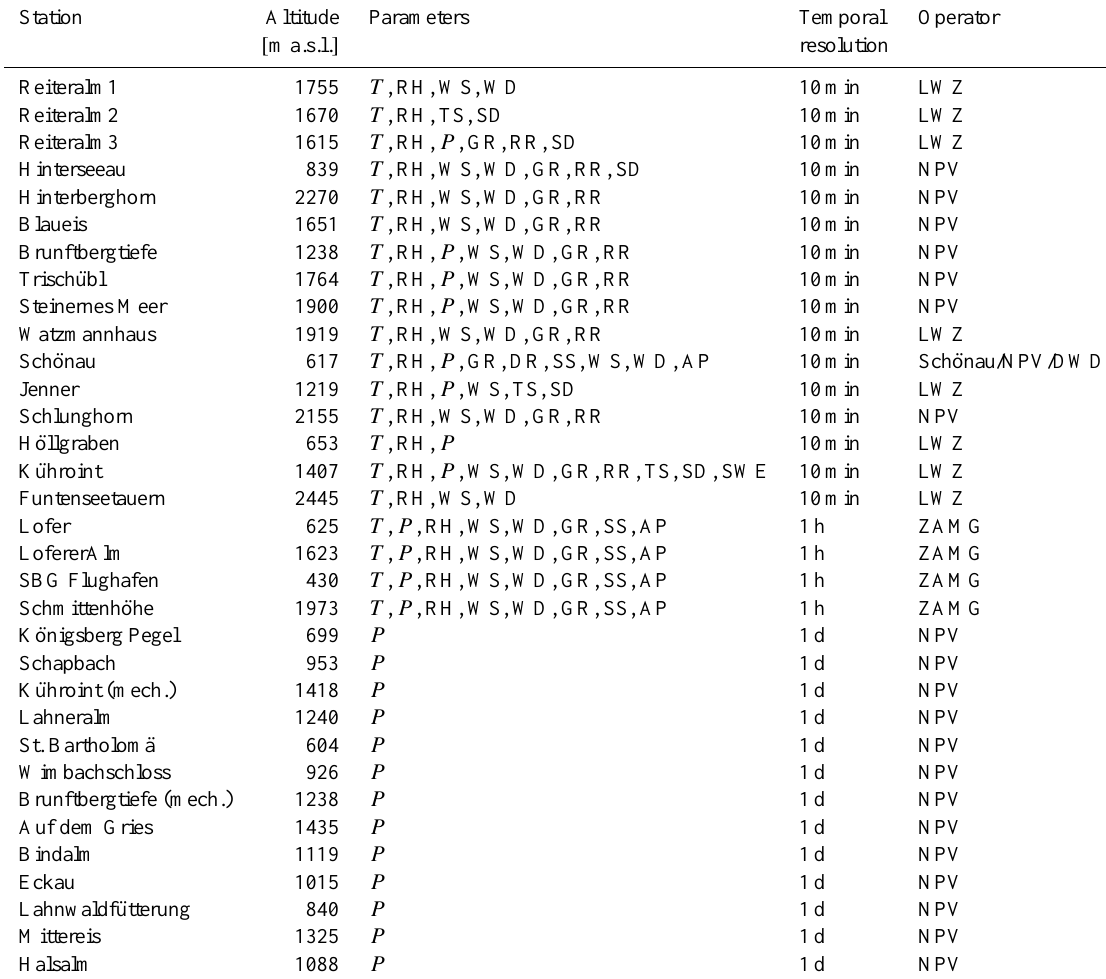
Table 1. Location, altitute and parameters and temporal resolution of the meteorological stations used for our investigation. Station Altitude Parameters Temporal Operator [ ma.s.l. ]